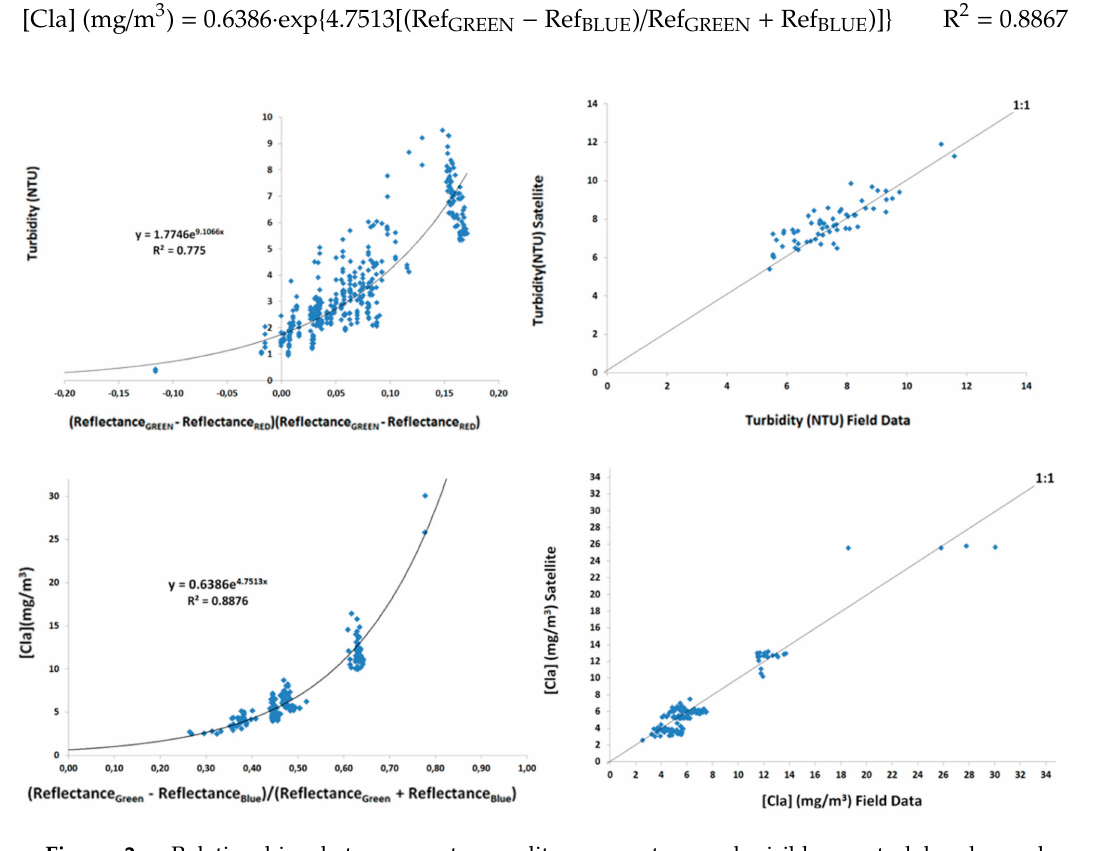
Figure 2. Relationships between water quality parameters and visible spectral bands, and their